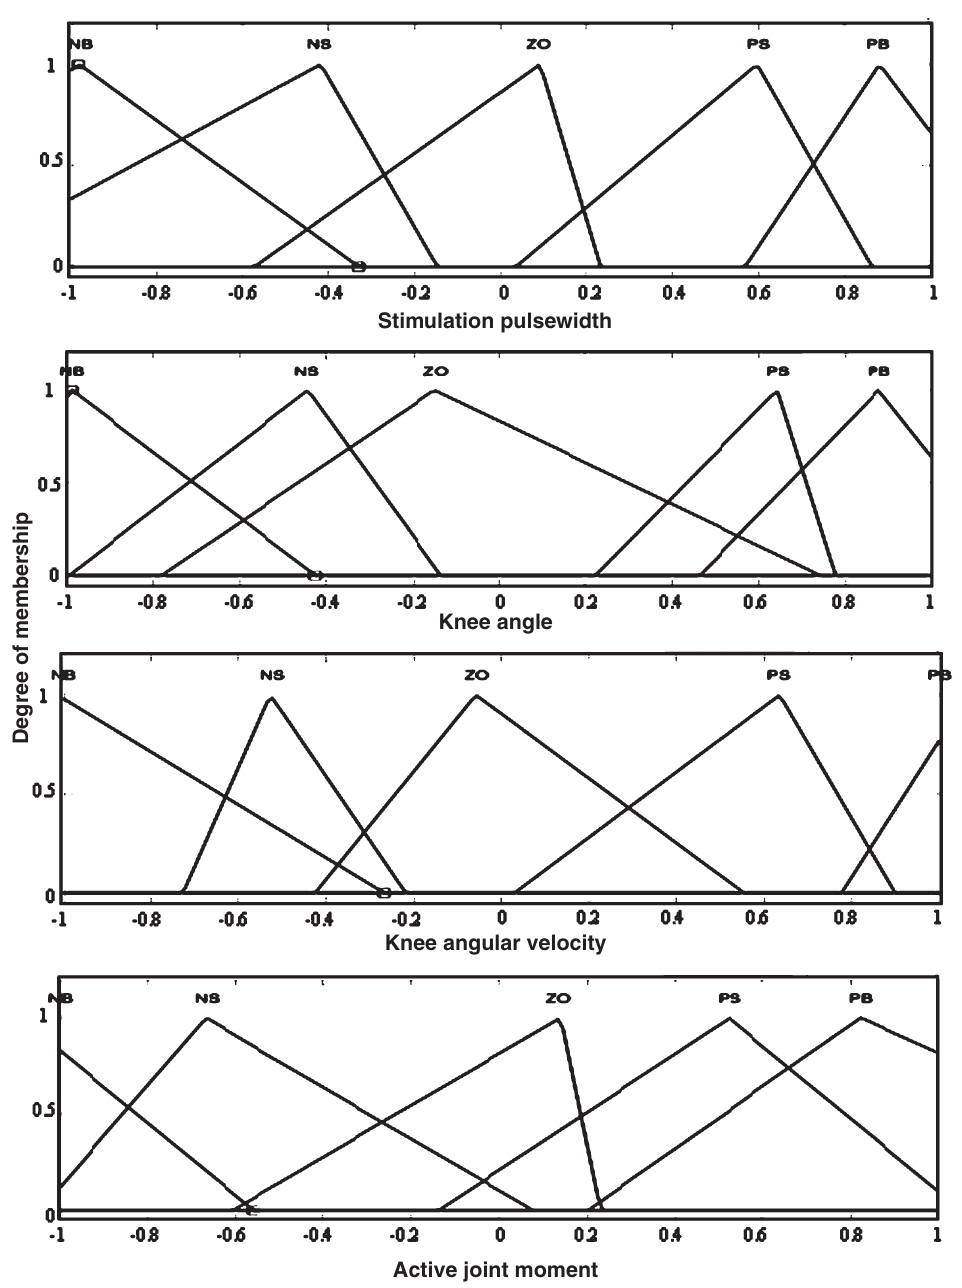
Fig. 11. Optimised membership functions of active properties